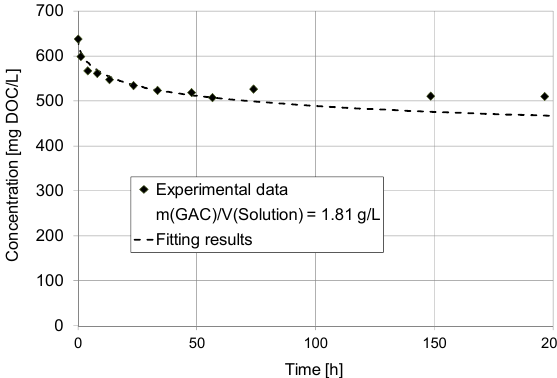
Figure 5. Data from a batch test with pre-treated HTC fine mulch PW and fit of the film-homogeneous diffusion model.